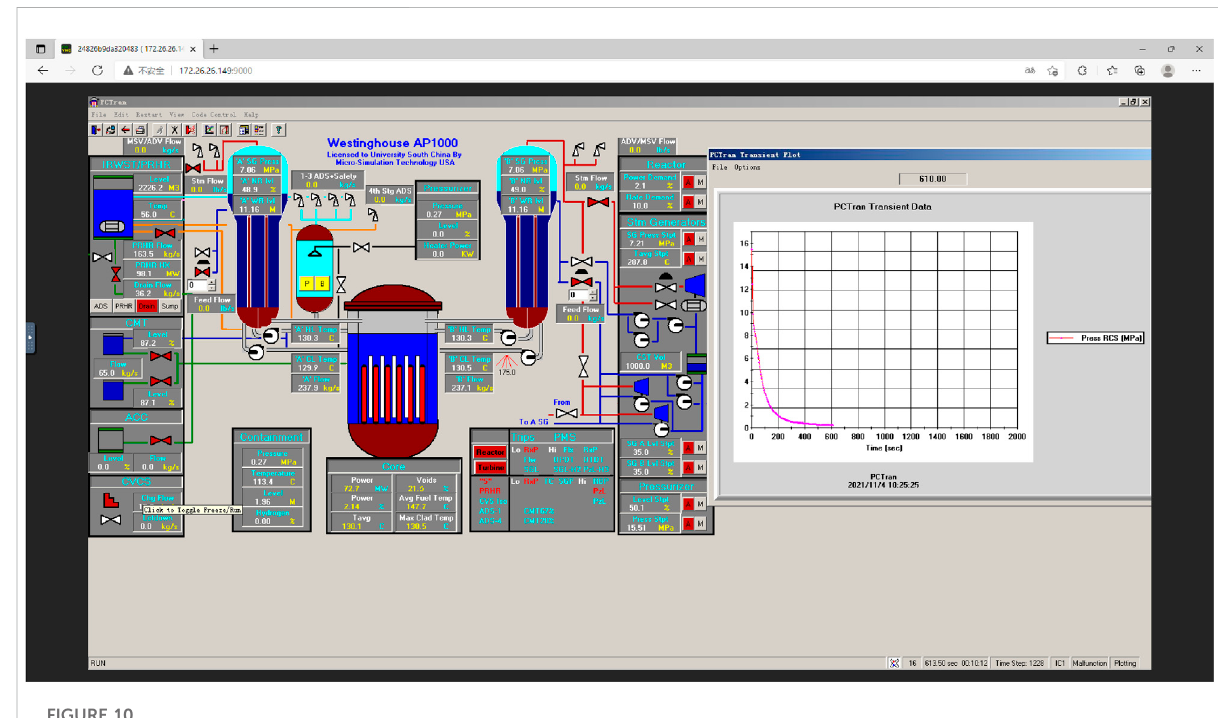
Operation of the microsoft edge on the